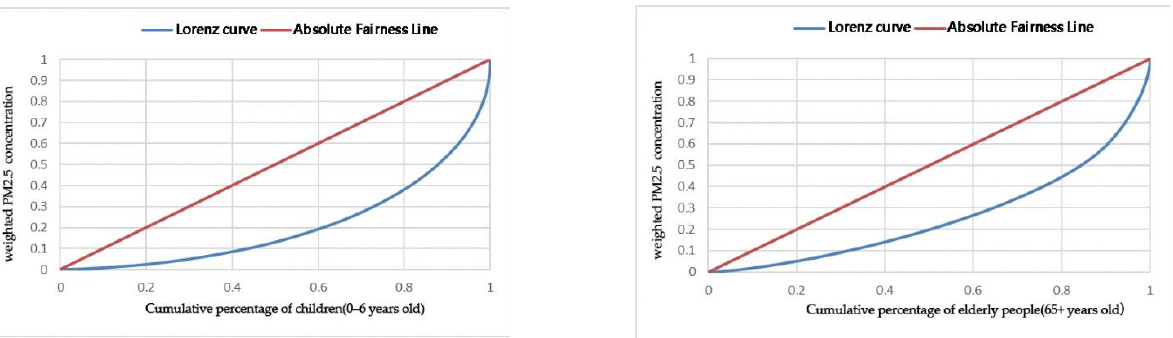
Figure 9. PM 2.5 -Lorenz curve for the elderly people and children.